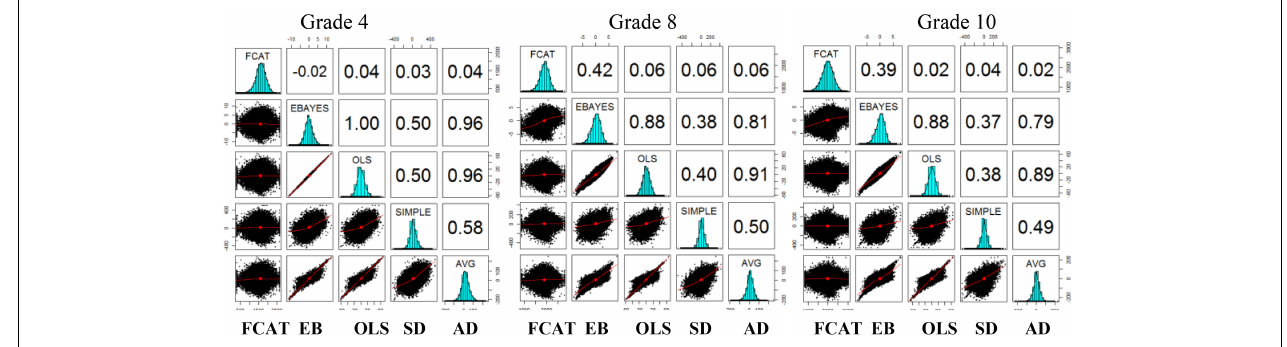
FIGURE 1 | Matrix scatterplot depicting Pearson correlations (upper diagonal) , histograms (diagonal), and scatterplots (lower diagonal) for the FCAT and growth measures, by grade, 2009/10. FCAT, Florida Comprehensive Assessment Test; EB, empirical Bayes; OLS, ordinary least squares; SD, simple difference; AD, average